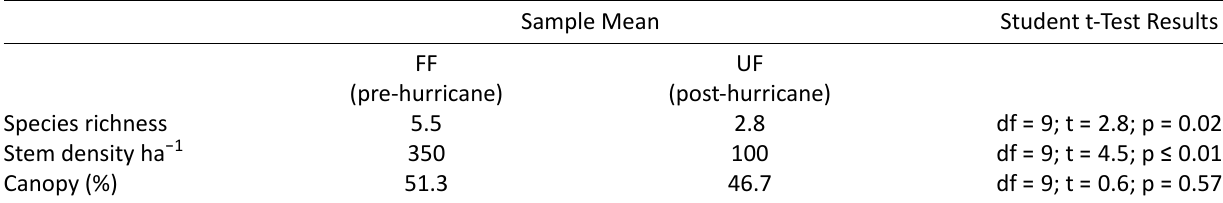
Table 2. Student t‐test results for comparison of 10 FF and 10 UF plots in Miami‐Dade County,